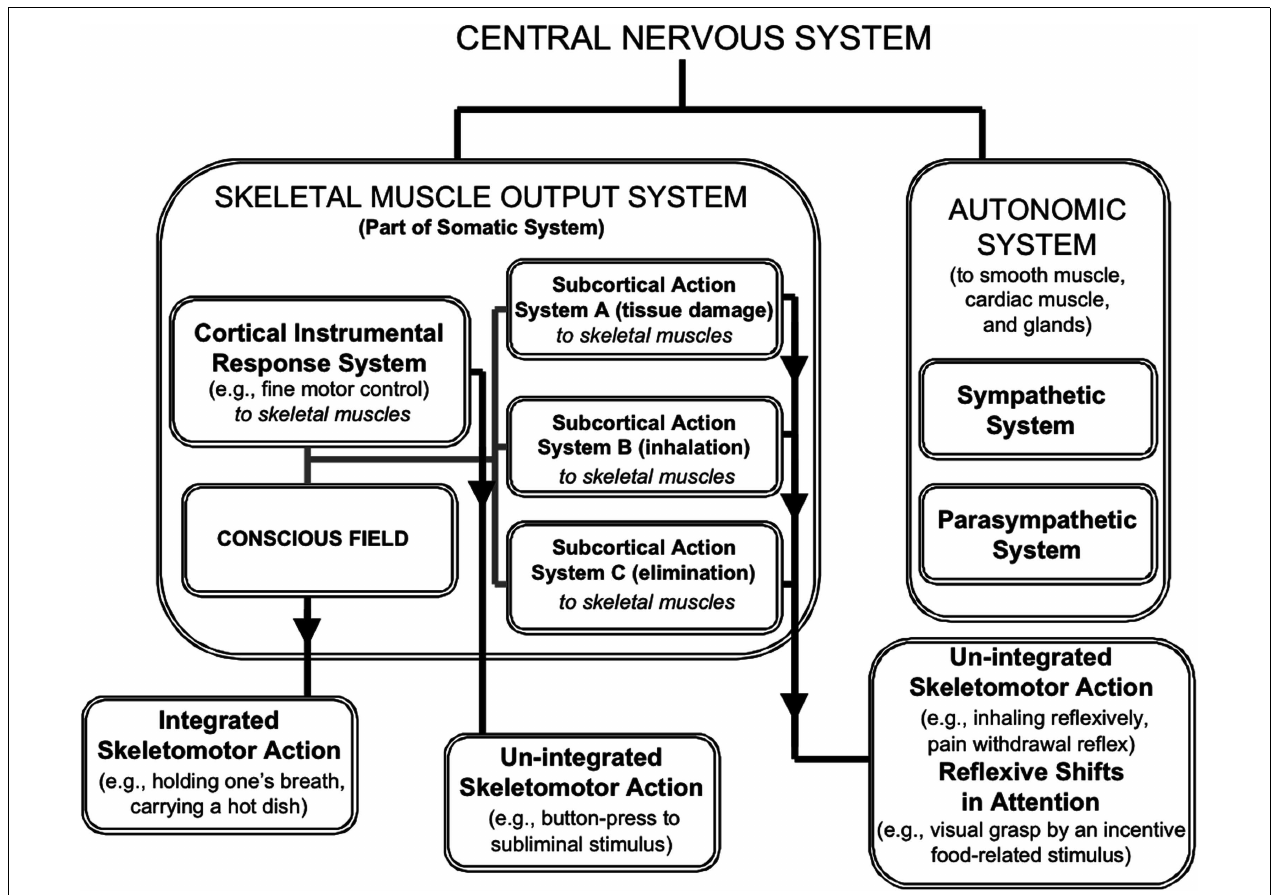
damage and elimination).The instrumental system can control fine motor acts through ideomotor processing. Afference binding within systems can be unconscious. Although response systems can influence action directly, as in the case of un-integrated actions, only in virtue of conscious states can multiple response systems interact and influence action collectively, as when one holds one’s